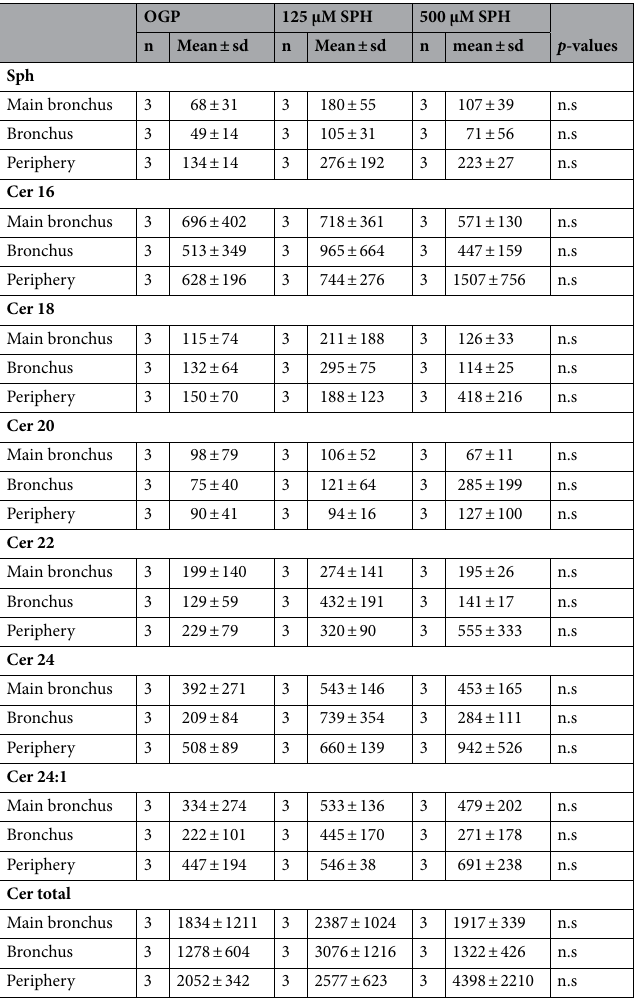
Table 2. Statistical analysis of mass spectrometry after inhalation of a 10% octylglucopyranoside (OGP), a 125 µM or a 500 µM sphingosine (SPH) solution (5 mL). The range of sphingosine (Sph), ceramide 16 (Cer 16), ceramide 18 (Cer 18), ceramide 20 (Cer20), ceramide 22 (Cer 22), ceramide 24 (Cer 24), ceramide 24:1 (Cer 24:1) and ceramide total (Cer total) in pmol/mg protein. Tissue samples from main bronchus, bronchus and periphery were collected after a 4-h EVLP run. Given is the mean ± SD,